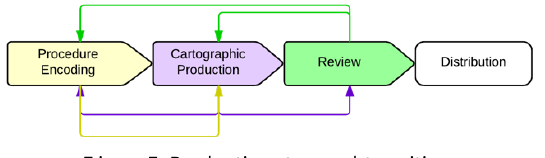
Figure 7. Production steps and transitions